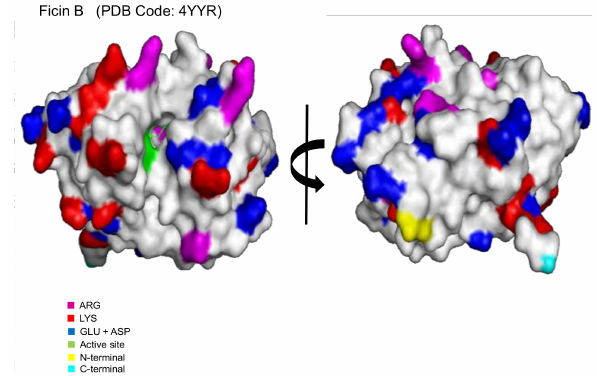
Figure 3. 3D surface structure model of Ficin B obtained from the PDB and displayed using PyMol versus 0.99. Arg, Lys, Glu+Asp, -NH 2 terminal and -COOH terminal residues are indicated.